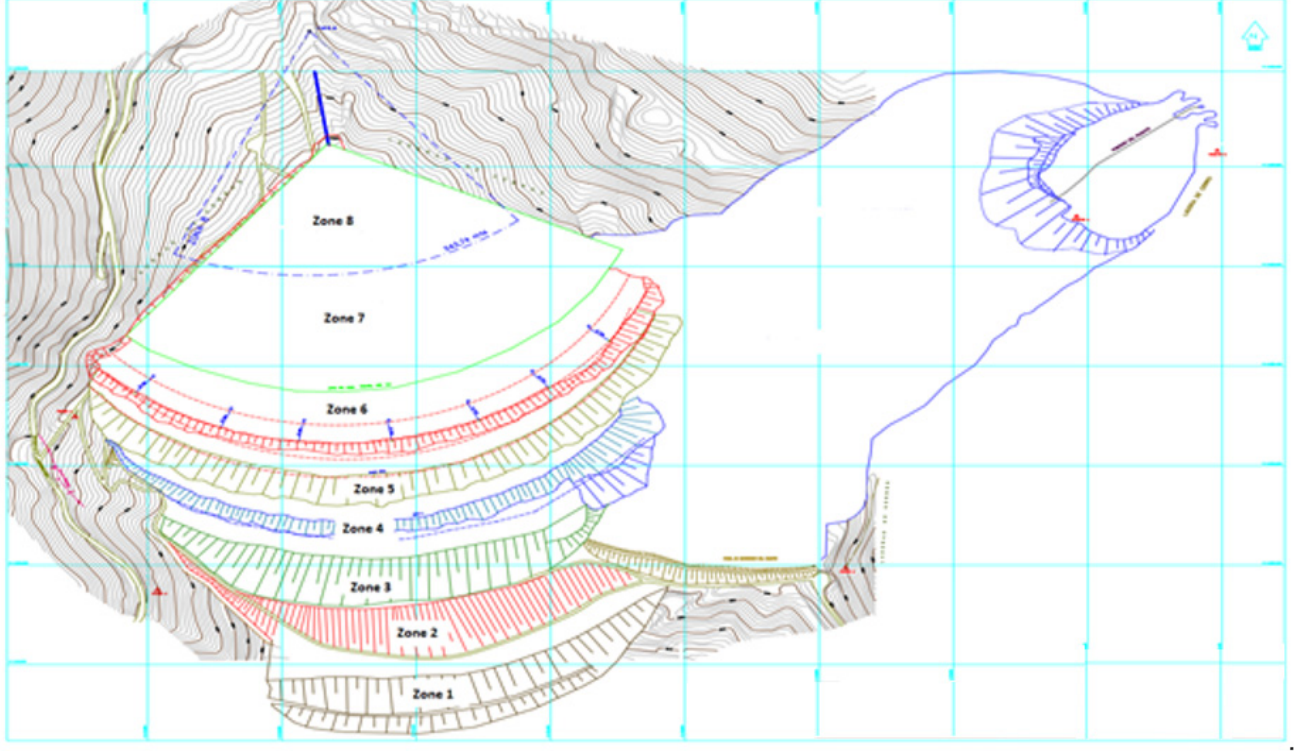
Figure 20. La Coipa Rako TSF Layout [24,58].